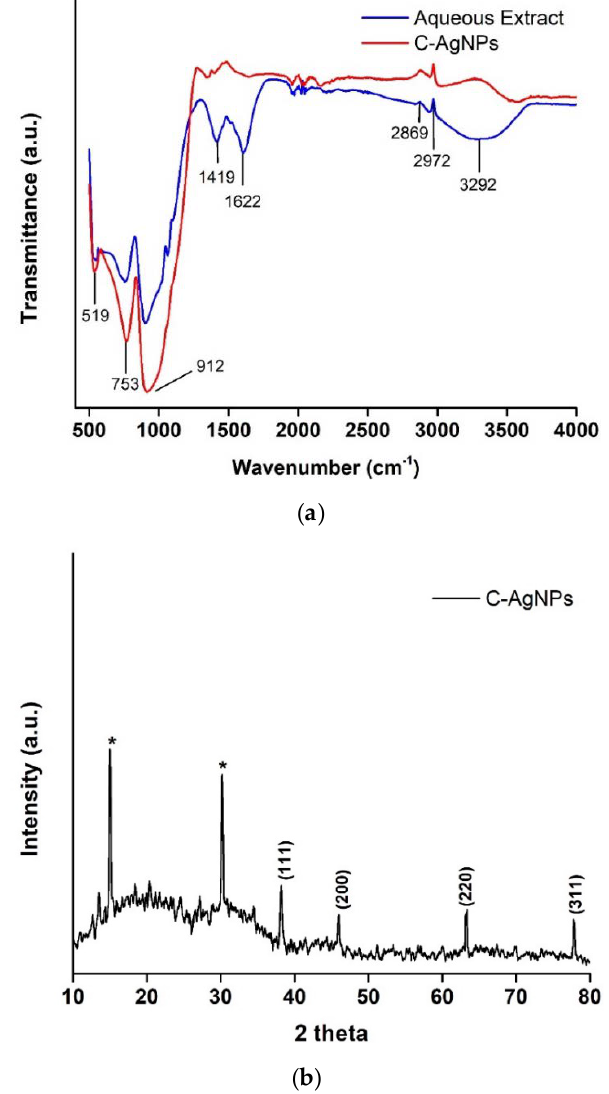
Figure 4. ( a ) FTIR spectra of Cascabela thevetia aqueous leaf extract and C-AgNPs, and ( b ) XRD pattern of C-AgNPs where Bragg reflections were matched exactly with face-centered cubic lattice structure of Ag. The peaks with steric were unassigned. The steric represents unidentified peaks probably due to unreacted carboxyl groups of gallic